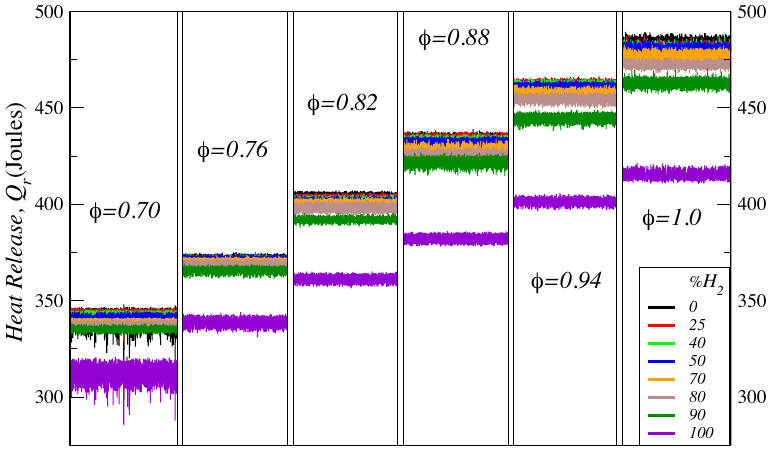
Figure 3. Simulated heat release time series for different fuel–air ratios, φ , and hydrogen concentrations, % H 2 . Each case consists of 10,000